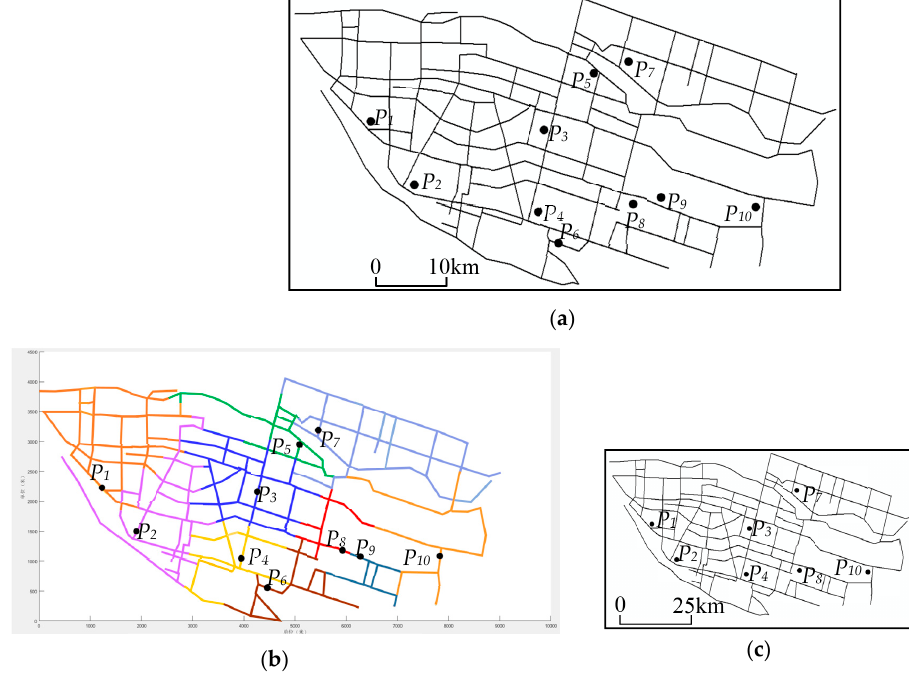
Figure 12. Experiment 1 for testing the new algorithm: ( a ) source data at scale 1:10K; ( b ) network Voronoi diagram of the points; and ( c ) generalized point data at scale 1:25K. The maps are not shown exactly to